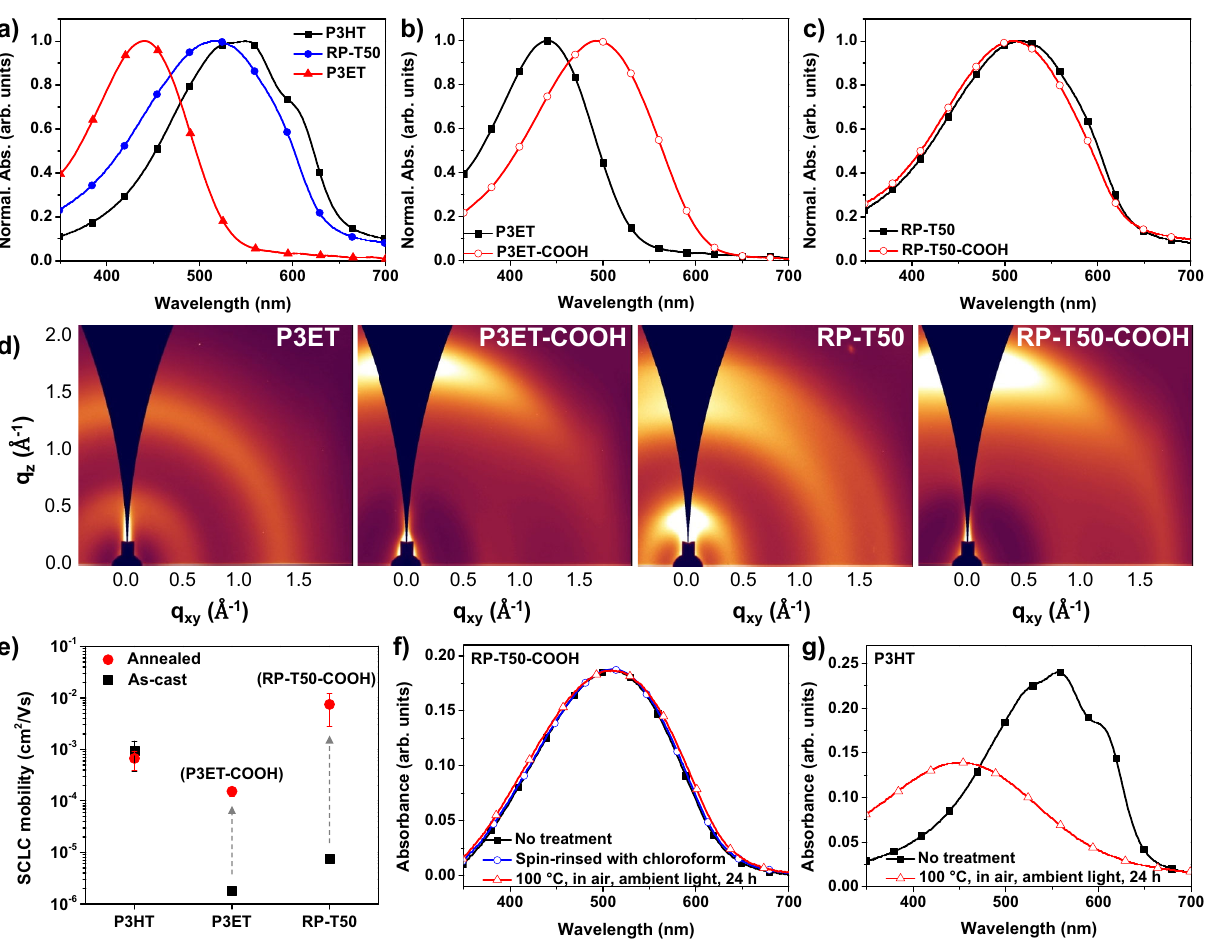
Fig. 2 Optical properties, microstructures, SCLC mobility and stability test. a Normalized UV – vis absorption spectra of as-cast P3HT, RP-T50 and P3ET fi lms. Normalized UV – vis absorption spectra of P3ET and P3ET – COOH fi lms ( b ) and RP-T50 and RP – T50 – COOH fi lms ( c ). d GIWAXS patterns of P3ET, P3ET – COOH, RP-T50 and RP – T50 – COOH fi lms. e SCLC mobilities of P3HT, RP-T50, and P3ET before and after annealing at 150 °C for 12 h. Error bars represent ± s.d. ( n = 2 – 4). f UV – vis absorption spectra of RP – T50 – COOH before and after stability test (spin-rinsed with chloroform only or heated at 100 °C, in air and under continuous ambient light for 24 h after spin-rinsed with chloroform). g UV – vis absorption spectra of P3HT before and after stability test (heated at 100 °C, in air and under continuous ambient light for 24